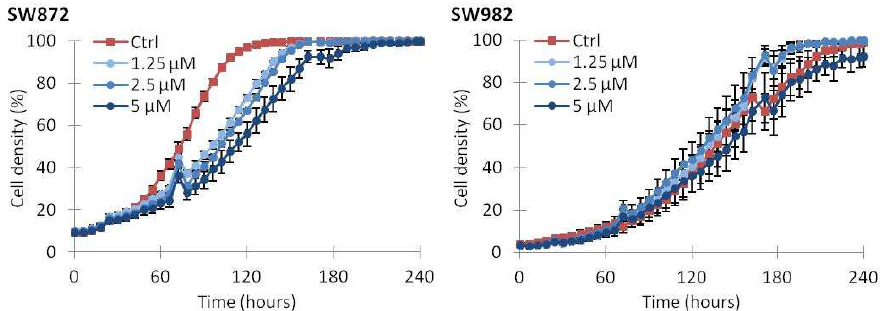
Figure 3. Effect on cell growth during vemurafenib treatment. Cells were treated with the indicated concentrations of vemurafenib or vehicle only (Ctrl) and monitored by time-lapse microscopy. Growth medium supplemented with drug was replaced twice a week. Irregularities in growth curves are caused by loss of poorly attached cells by media change. One representative experiment is shown ( n = 2). Error bars represent standard error of mean (SEM) of three technical replicates.